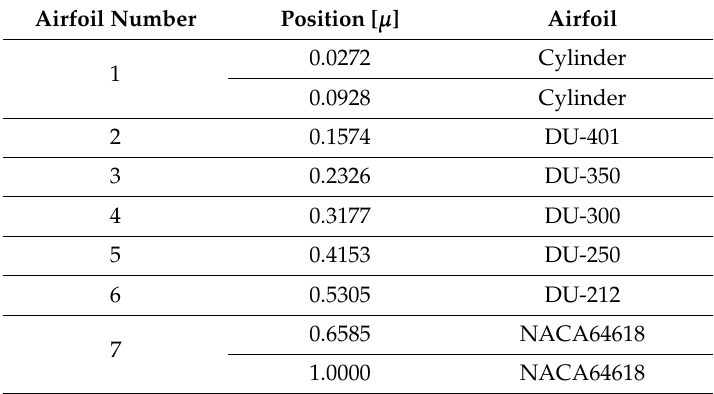
Figure 3. Aerodynamic coefficients and airfoil shapes. ( a ) Aerodynamic coefficients of the airfoils. ( b ) Airfoil shapes of NACA and DU series. Table 1. Airfoil distribution.